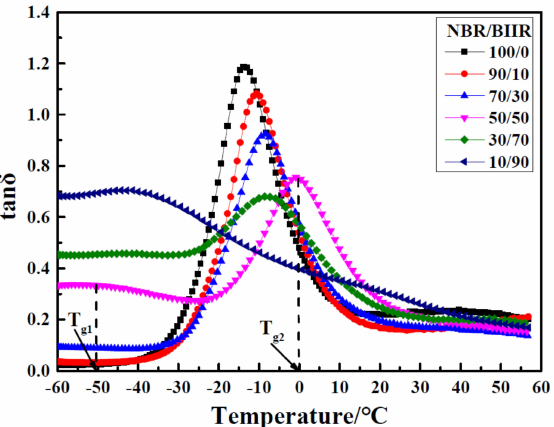
Figure 25. Damping loss factor versus temperature for NBR/BIIR with various blend ratios [31].